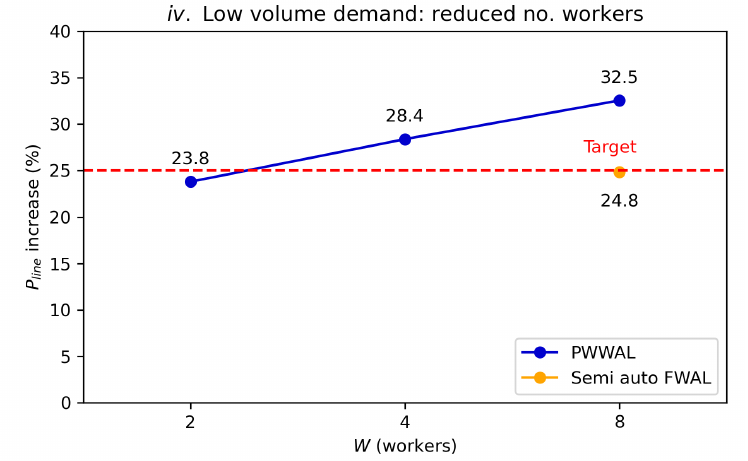
Figure 6. Line productivity improvement of semiautomated FW and parallel walking-worker with respect to manual FW line configuration for reduced no. of workers ( W , scenario iv ).